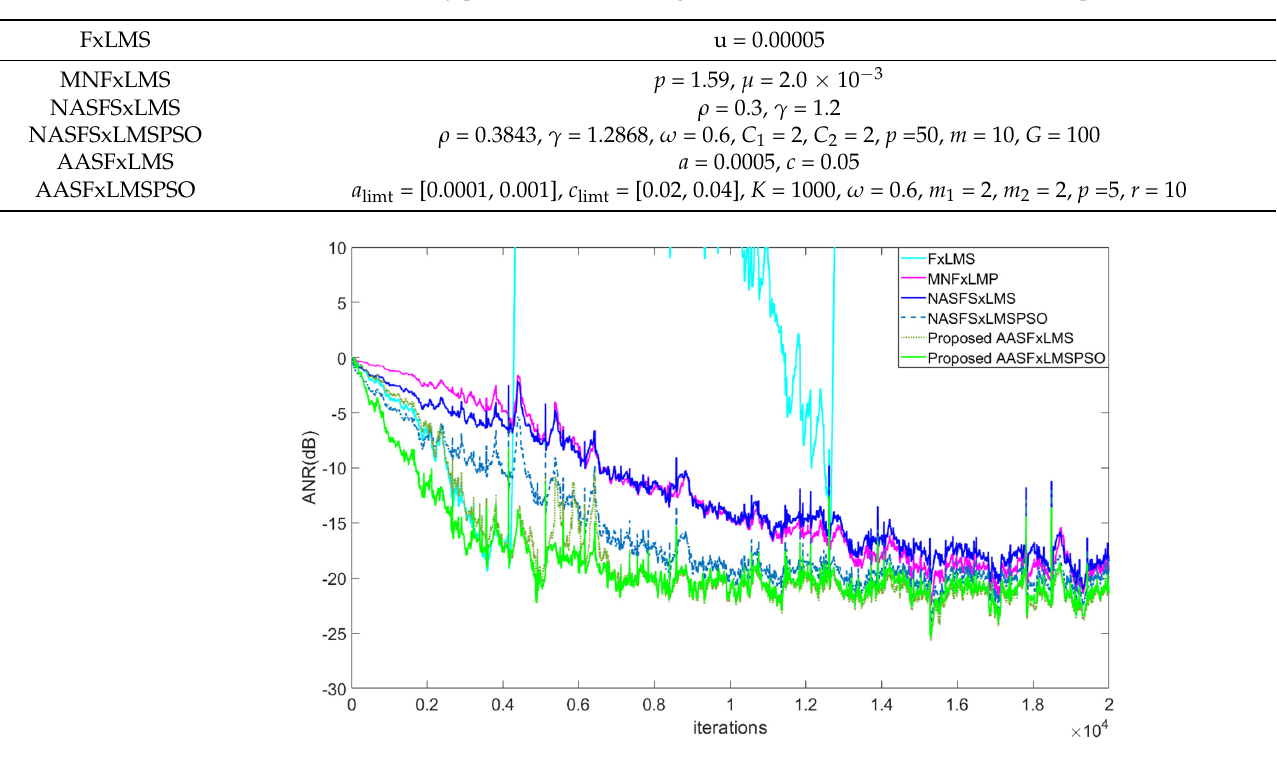
Table 3. The key parameters of each algorithm in MATLAB simulation of Example 3.